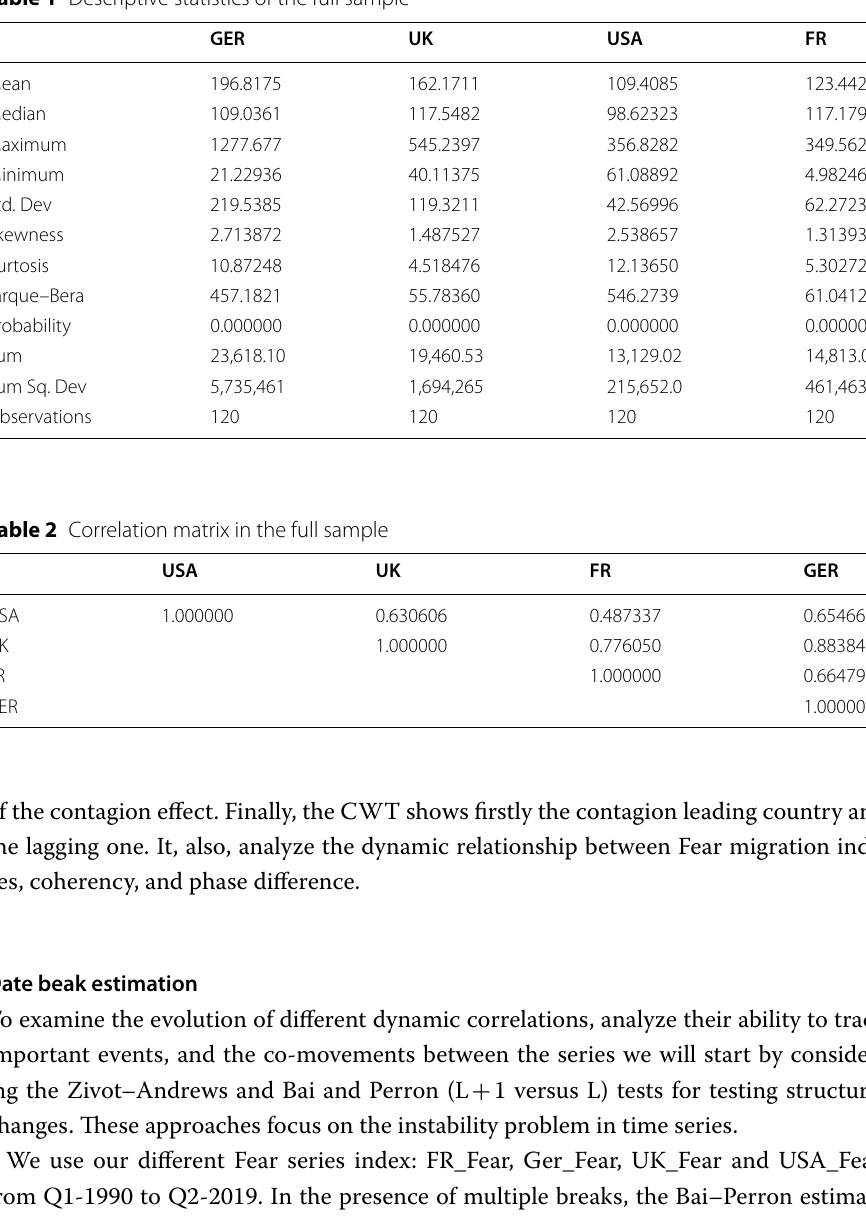
Table 1 Descriptive statistics of the full sample